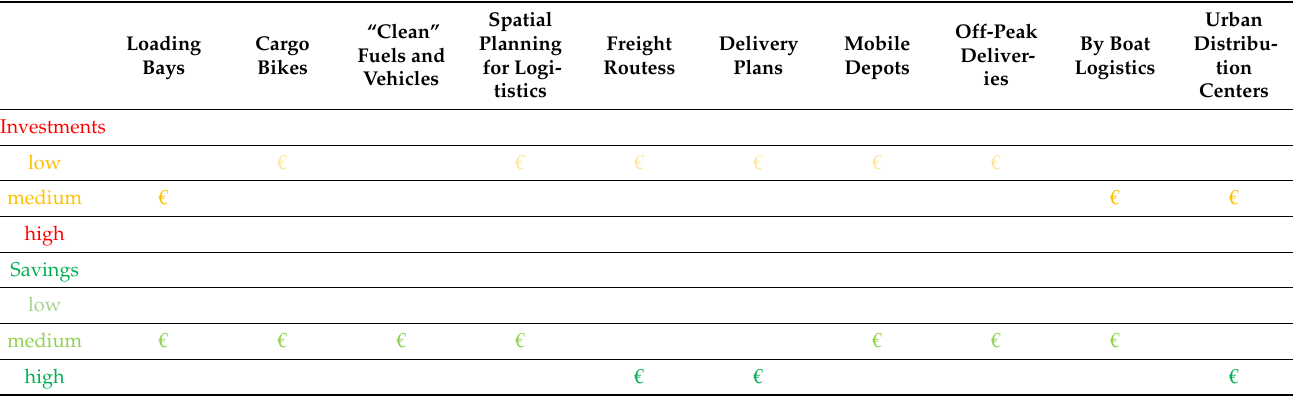
Table 2. Investments and savings of chosen city logistics